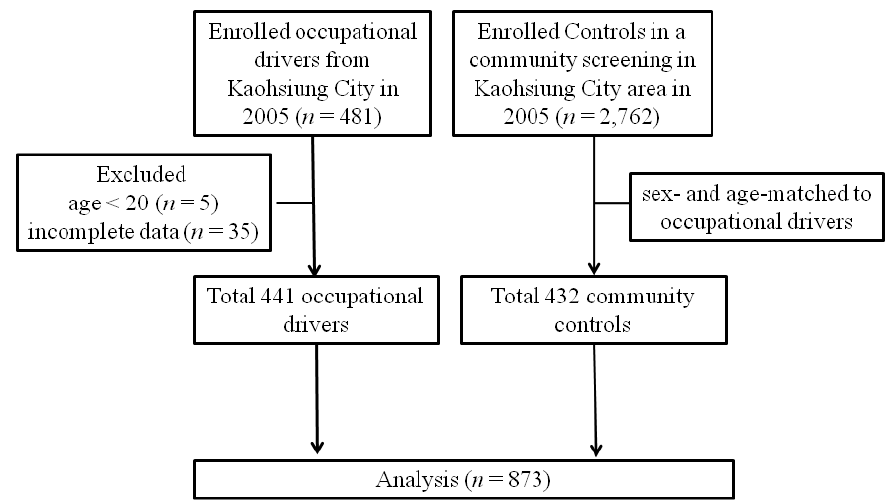
Figure 4. A flowchart of participant